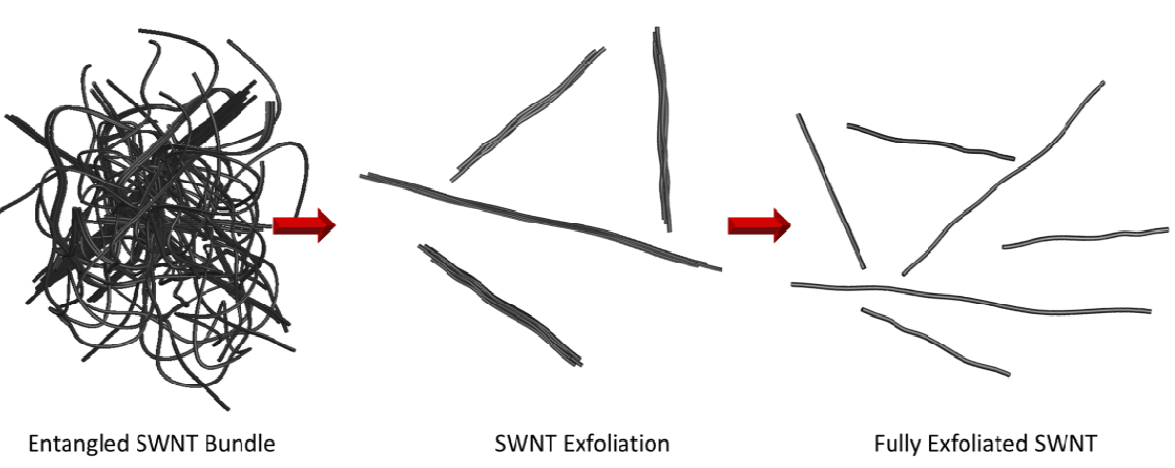
Figure 5. Schematic representing the disentanglement, exfoliation, and length scission processes for SWNT bundles during